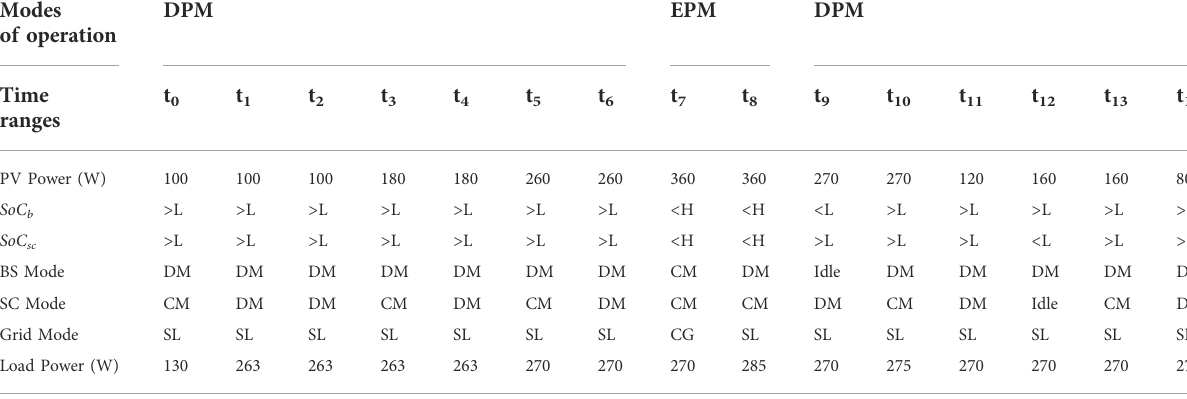
TABLE 4 Proposed EMS power changes in various operation